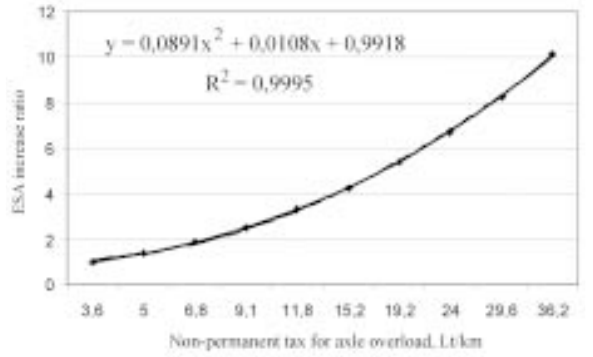
Fig 2. Payment for 1 km run depending on ESA